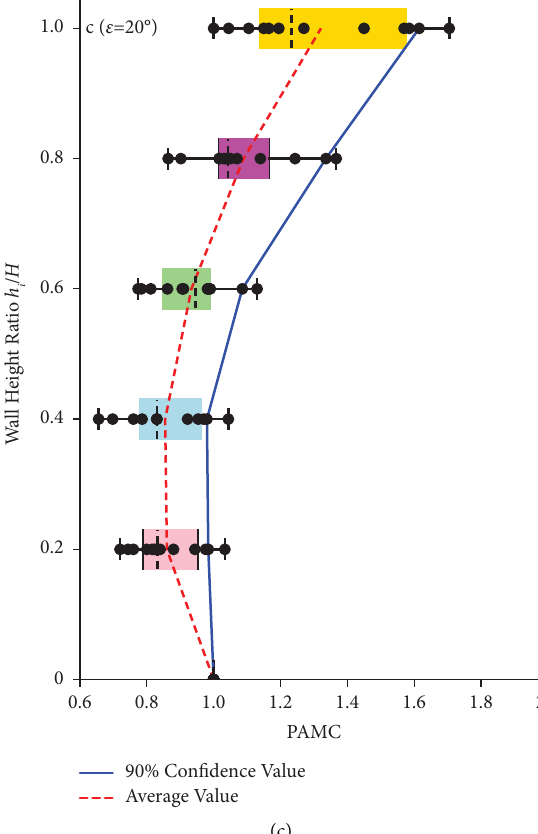
Figure 8: Analysis diagram of the acquisition method of the distribution coefcient ψ